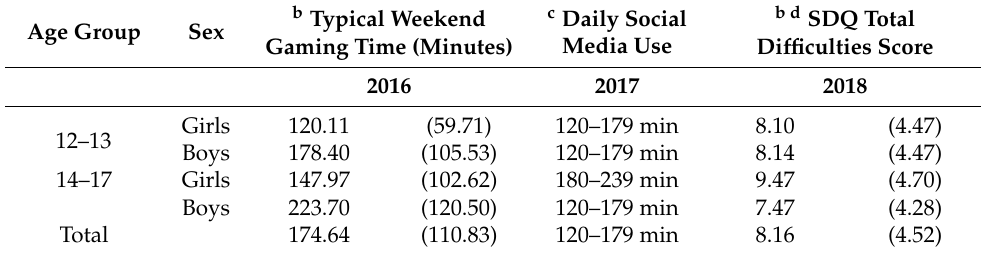
Table A2. Distribution of validation measures across the three samples a .